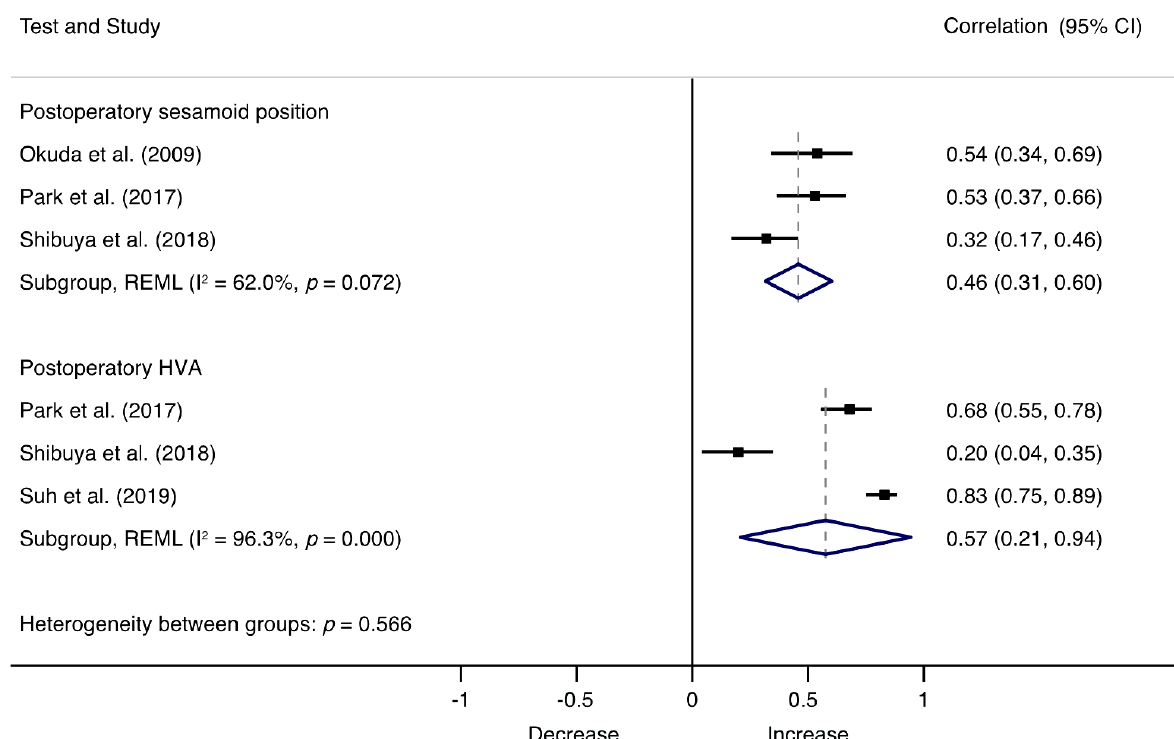
Figure 4. Forest plot showing the correlation of HV recurrence and postoperatory factors for each study. Squares represent pooled effect size for each subgroup analysis, and the diamond represents the overall pooled effect size. HVA, hallux valgus angle.